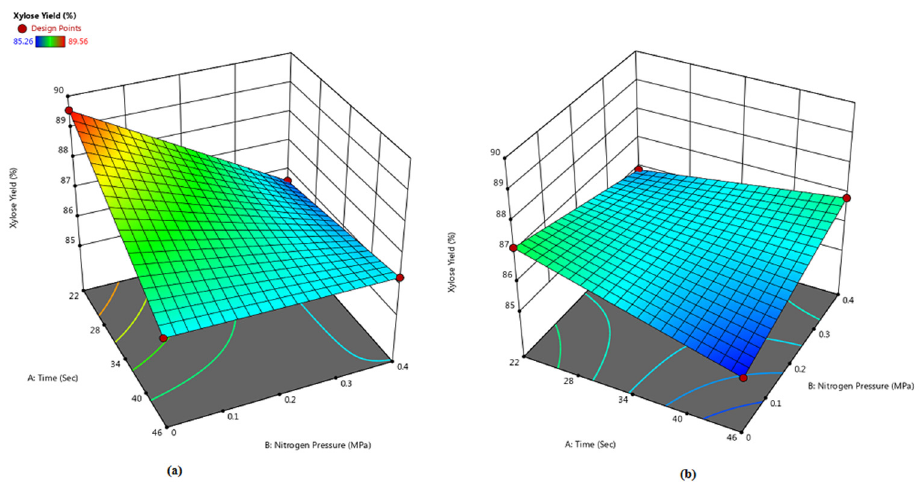
Figure 5. Response surface of xylose yield in solid fraction ( a ) 4 g biomass loading ( b ) 8 g biomass loading.